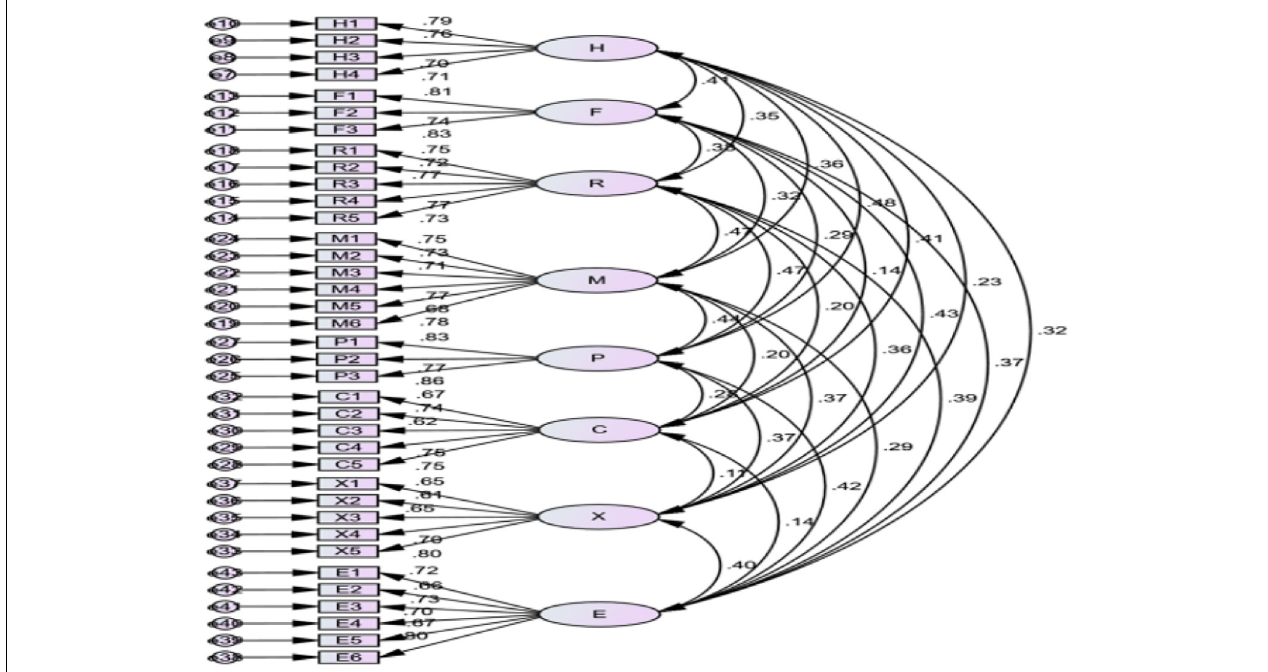
FIGURE 2 | The competitive advantage measurement